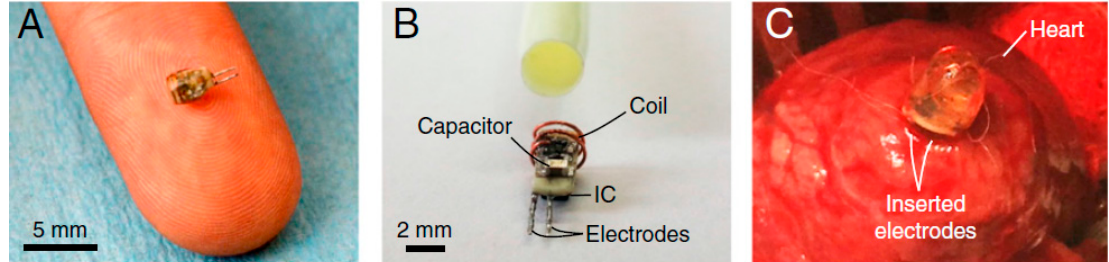
( c ) Figure 33. Wireless peripheral nerve neuromodulation system [160]. ( a ) Conformal wireless powering transmitter. ( b ) Design of wireless cuff electrodes. ( c ) Fluoroscopy images of the implanted wireless cuff and transmitter on skin. Copyright © 2017 Tanabe et al. 5.4.3. Capsule Endoscopy In [161], a multi-band conformal antenna is presented for 402–405 MHz and lower GHz frequency for CE applications. Figure 34a shows the fabricated conformal antenna printed on a cylindrical capsule of 10.25 mm outer diameter and 20.5 mm length. A two-port TX coil was designed for power transmission [156]. The proposed model was tested in an American Society for Testing and